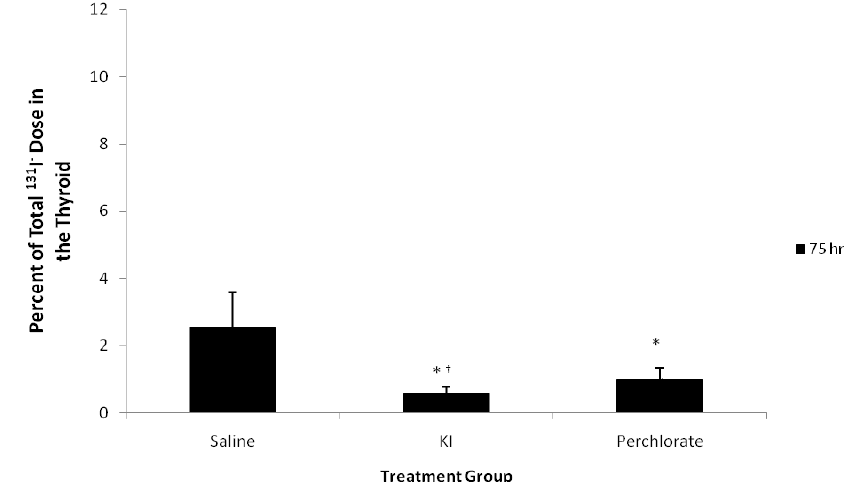
Figure 3. ( a ) 75 hour percent of total 131 I − in the thyroid of Group 1 male rats dosed with 131 I − via gavage followed by saline, KI (30 mg/kg), or perchlorate (30 mg/kg) as described in Figure 1a. Data are means ± standard deviation (n = 12); ( b ) 75 hour + T total 131 I − in the thyroid of Group 2 male rats dosed with 131 I − via gavage followed by saline, KI (30 mg/kg), or perchlorate (30 mg/kg) and dosed with T described in Figure 1b. Data are means ± standard deviation (n =